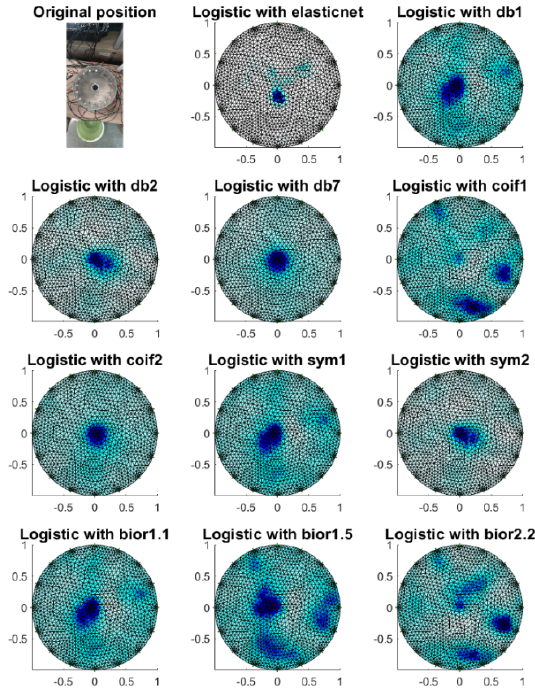
Figure 12. Image reconstruction with the centrally placed phantom.